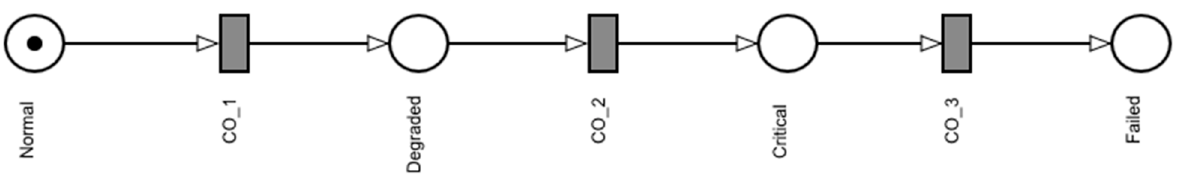
Figure 5. Degradation model on TimeNET.